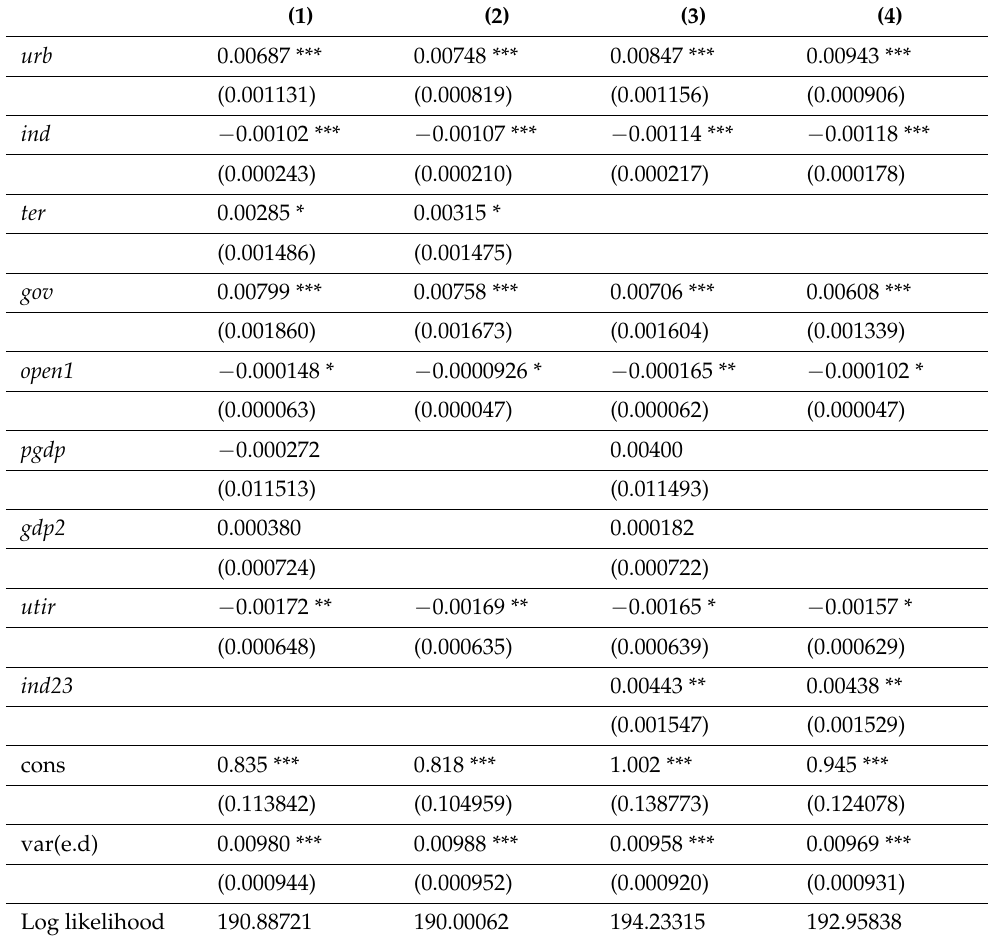
Table 7. Tobit robustness test